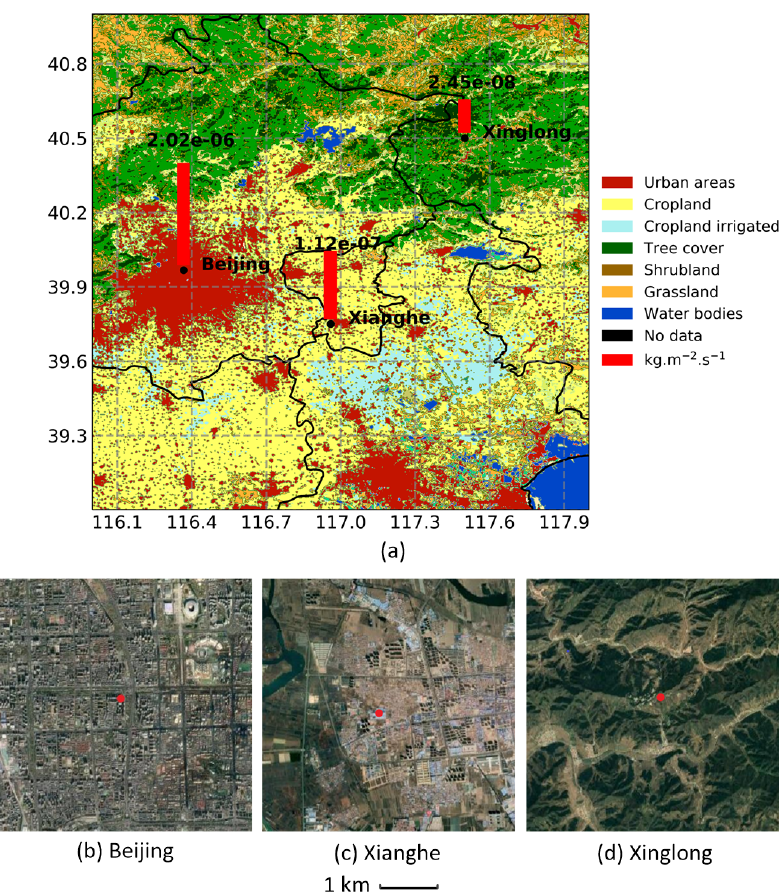
Figure 1. (a) The location of three sites at Beijing (BJ, 39.96 ◦ N, 116.36 ◦ E; 49ma . s . l . ), Xianghe (XH, 39.75 ◦ N, 116.96 ◦ E; 30ma . s . l . ), and Xinglong (XL, 40.40 ◦ N, 117.50 ◦ E; 940ma . s . l . ), together with the land cover in this area. The red bars are the carbon dioxide emissions at the three sites based on the EDGAR data. The maps within ∼ 2km of (b) BJ, (c) XH, and (d) XL are from ©Google Maps (https: //www.google.com/maps, last access: 20 July